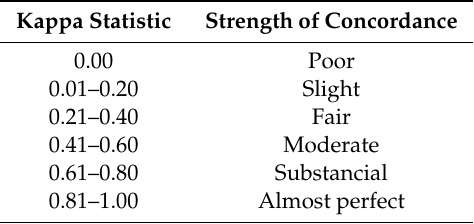
Table 11. Strength of concordance for kappa